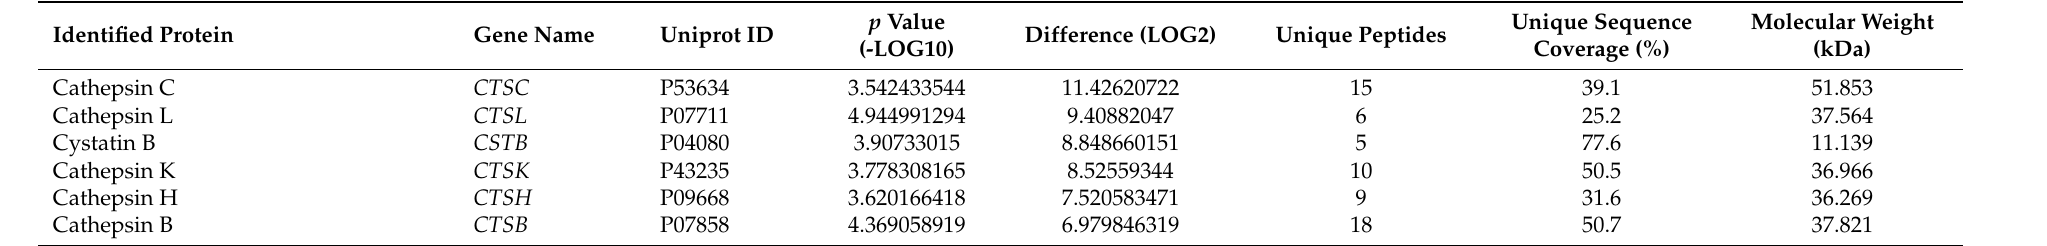
Table 2. Proteins pulled down by variant B cystatin